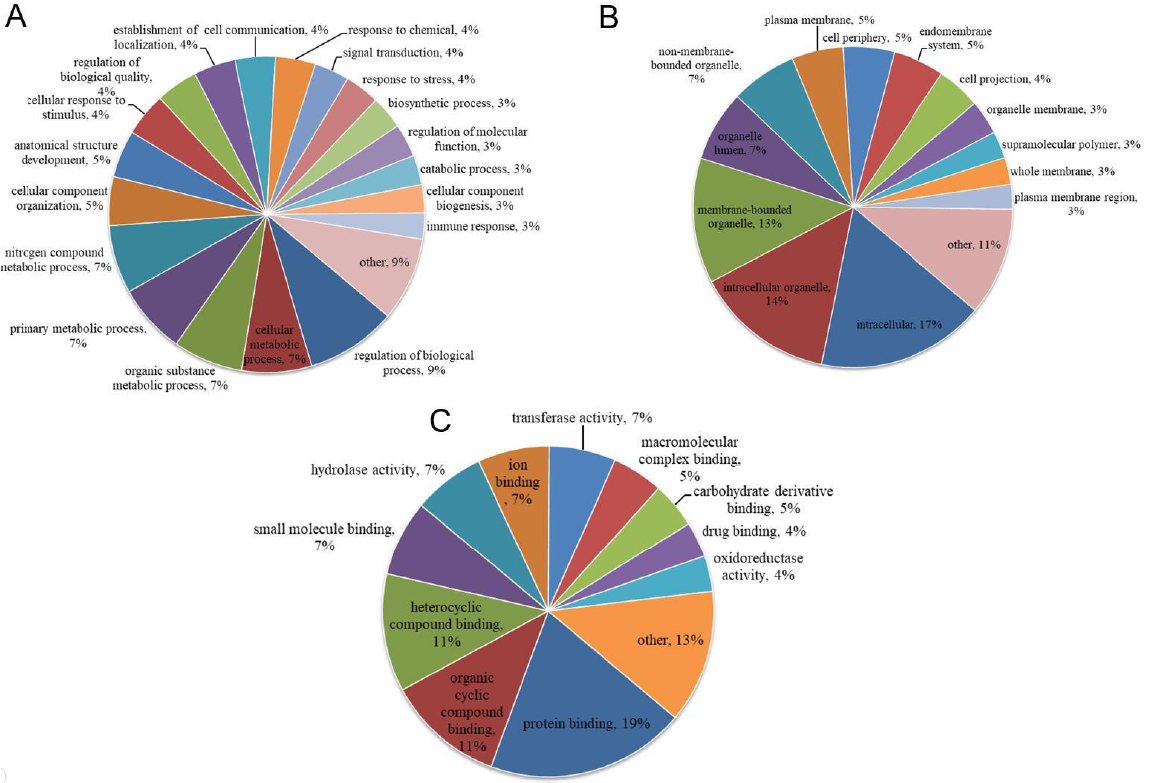
Figure 3. Statistical distribution chart of interferon-stimulated gene product 15 (ISG15)-conjugated proteins under each Gene Ontology (GO) category. ( A ) Distribution chart of identified proteins under the GO category of biological process. ( B ) Distribution chart of identified proteins under the GO category of cellular component, ( C ) Distribution chart of identified proteins under the GO category of molecular function.